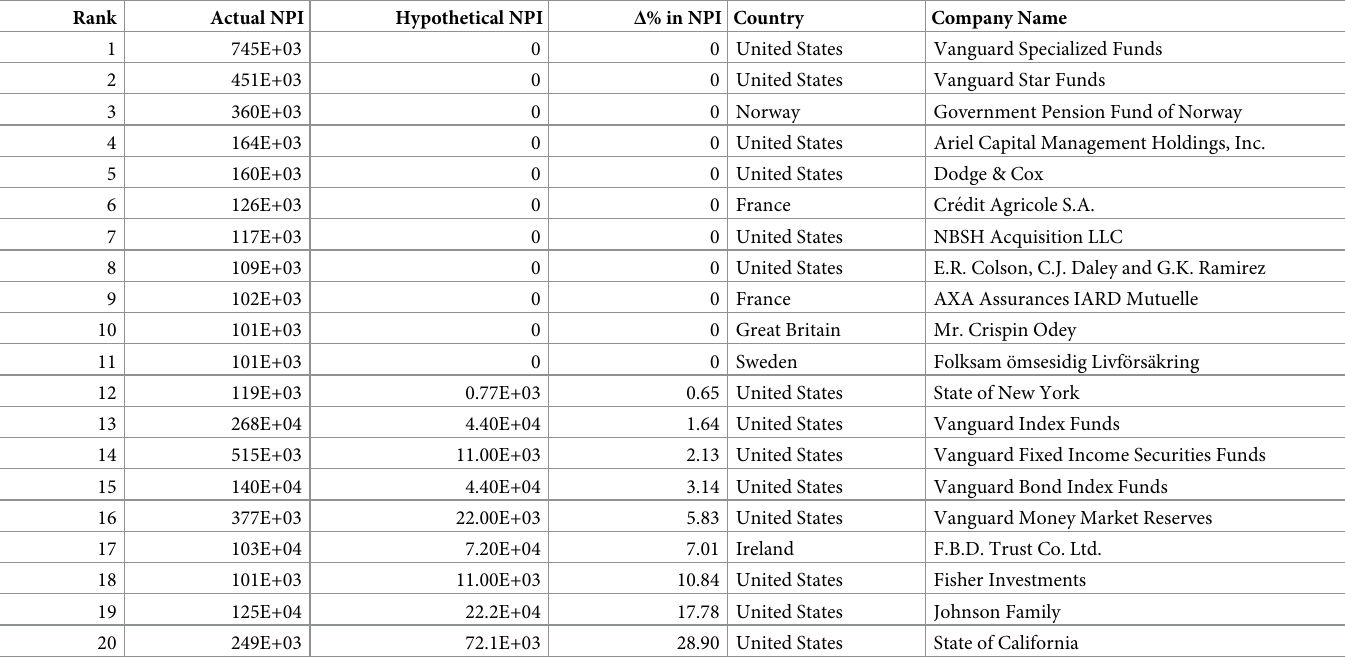
Table 9. Equity funds and inflated corporate control over arms manufacturers.